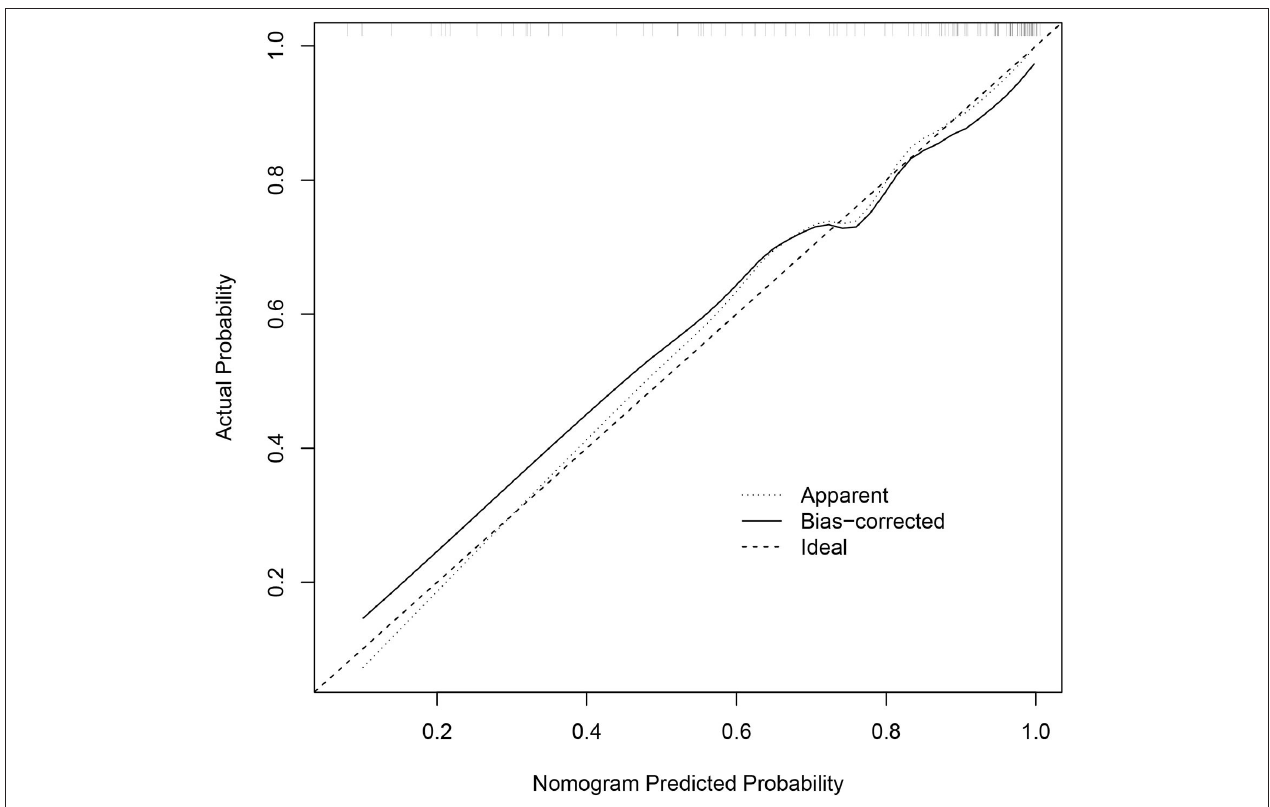
FIGURE 2 | Calibration curves of the nomogram prediction. The x -axis and the y -axis represent the nomogram prediction and the actual situation, respectively. The diagonal line shows that the forecast is exactly what happened. The more the solid line matches the diagonal , the better the predictive